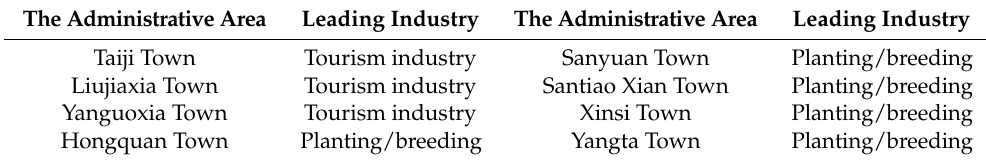
Table 5. Basic information of empirical objects of ecological migration area in Liujiaxia Reservoir Area. The Administrative